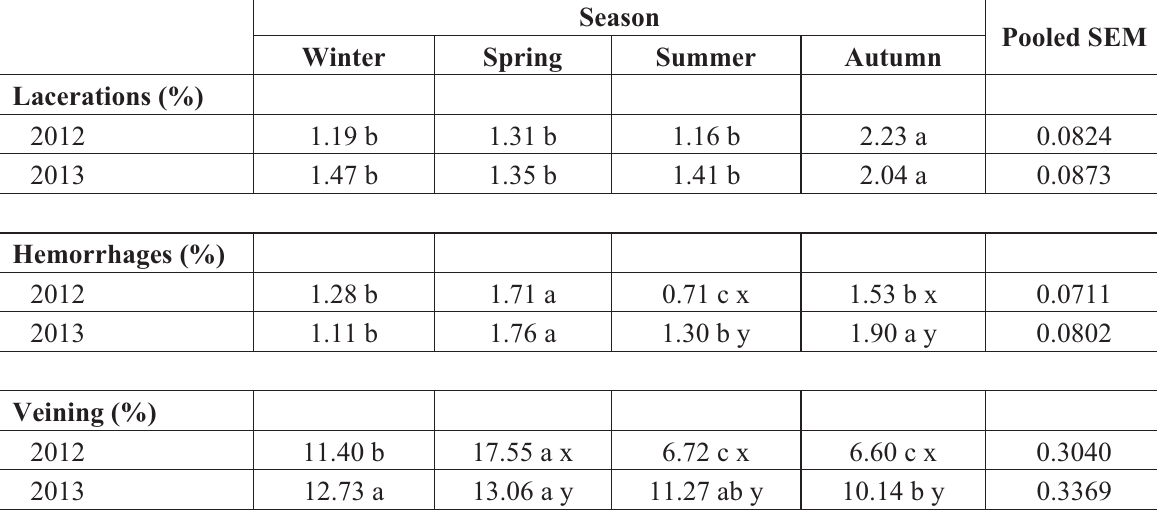
Table 7. Effect of interaction between season and year on the incidence of lacerations, hemorrhages and veining